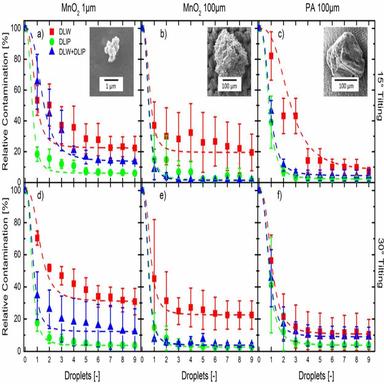
Remaining relative contamination in percent as a function of the number of released water droplets on the DLW, DLIP and DLW + DLIP structured substrates for different contamination types: 1 µm MnO2 (a, d), 100 µm MnO2 (b, e) and 100 µm PA (c, f). The substrates were tilted at 15° (a–c) and 30°(d–f). The SEM inserts show a single particle of each contamination type. The lines are guides to the eye.